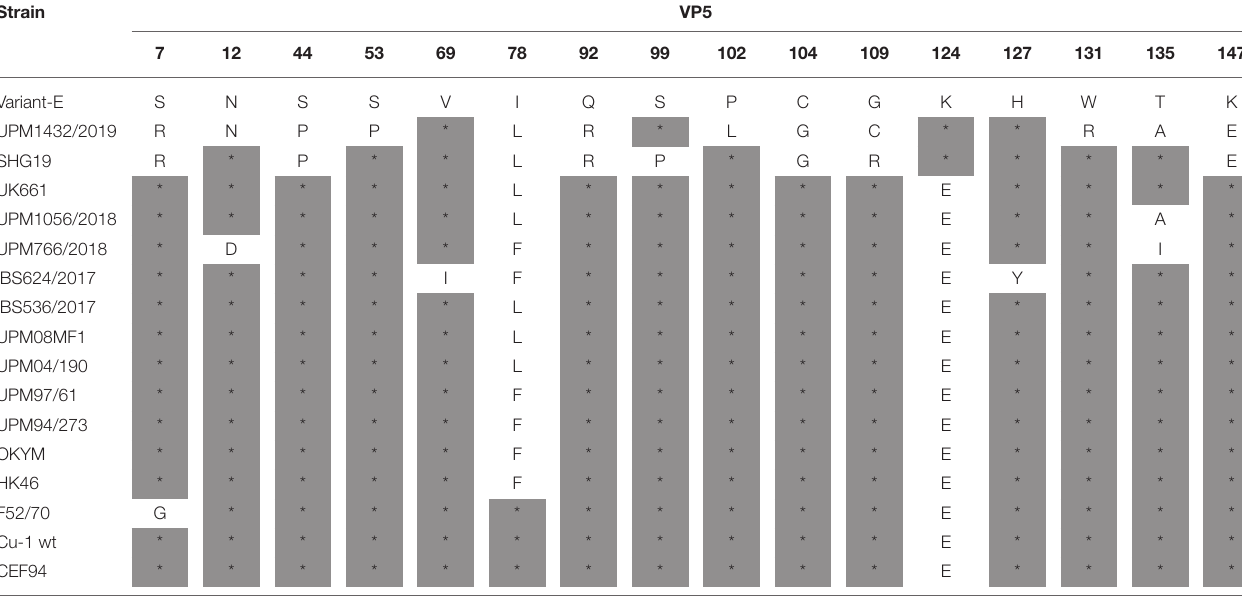
TABLE 3 | The characteristic amino acids in the VP5 gene of IBDV.